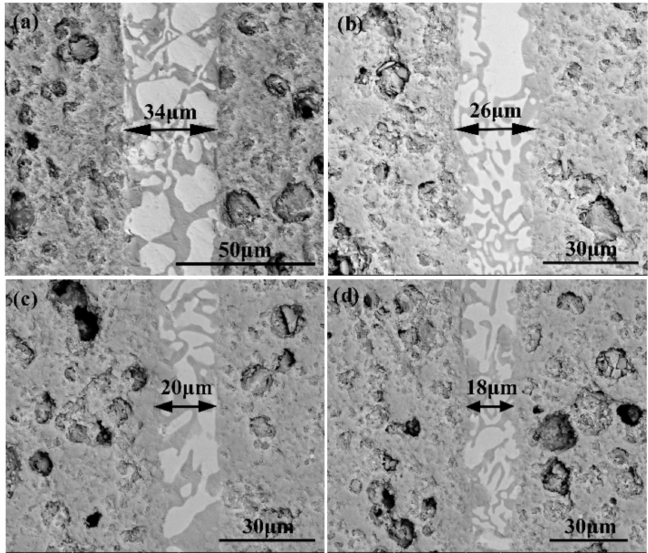
Figure 14. Microstructures of the carbon-coated welded joints bonded at different bonding tempera- tures for 10 min: ( a ) 1300 ◦ C, ( b ) 1320 ◦ C, ( c ) 1340 ◦ C, ( d ) 1360 ◦